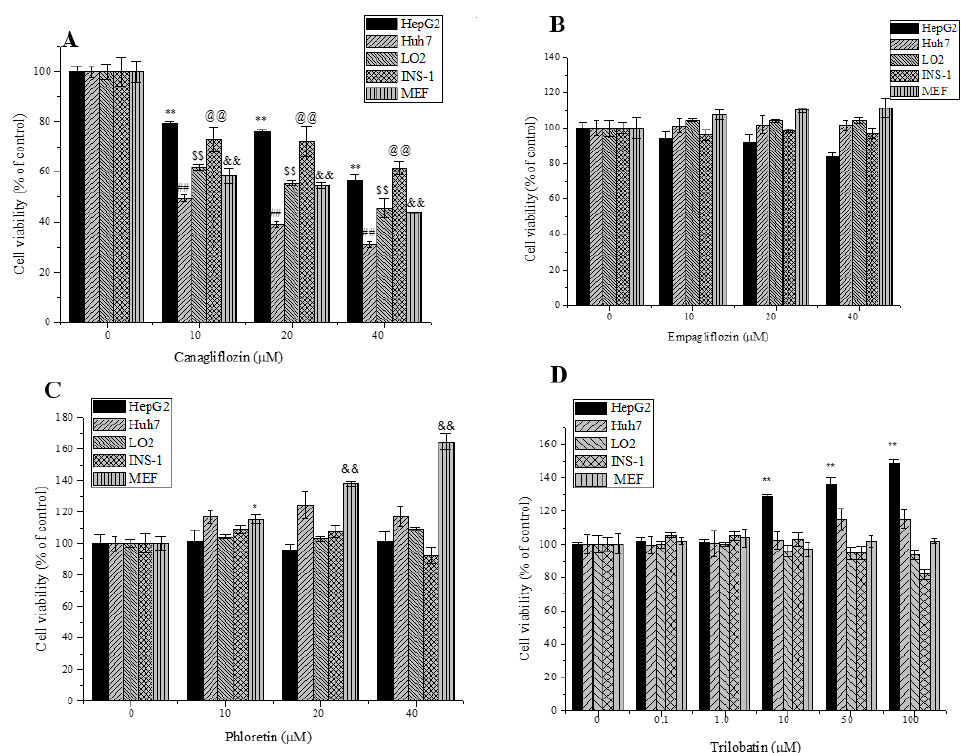
Figure 2. E ff ects of trilobatin, canagliflozin, empagliflozin and phloridzin on the proliferation of HepG2, Huh 7, LO2, INS-1, and MEF cell lines. After the cells were incubated with indicated concentrations of canagliflozin ( A ), empagliflozin ( B ), phloridzin ( C ), trilobatin ( D ) for 24 h, viable cell number was evaluated by MTT assay, Data are means ± SD ( n = 12), * p < 0.05, @@ , ## , ** and && , p < 0.01 vs. control. 2.3. E ff ects of Trilobatin, Phloridzin, Canagliflozin, and Empagliflozin on the Cell Cycle and DNA Replication in HepG2